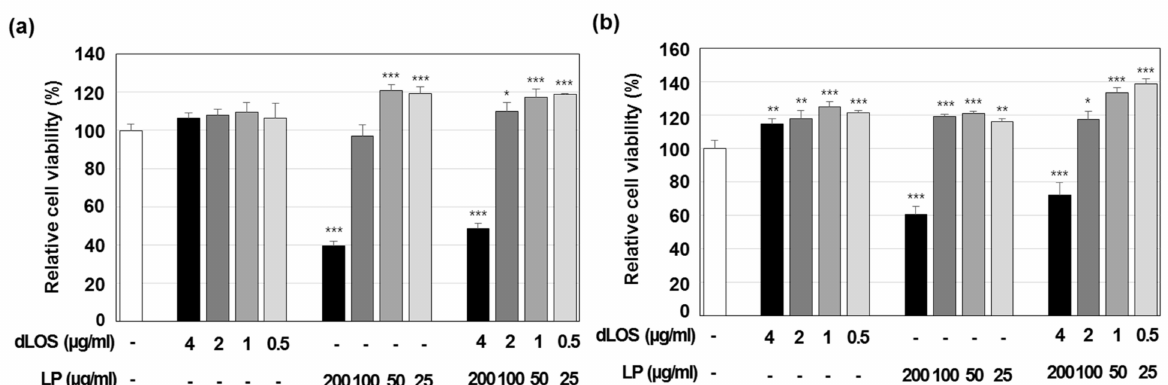
Figure 2. Cytotoxicity of liposomes (LP). MDCK ( a ) and DC2.4 ( b ) cells were incubated with liposomes, dLOS, or both for 24 h, and cell viability was assessed by MTT assays as described in Materials and Methods. Results are expressed as the mean ± SD of values obtained from triplicate assays, and the data shown are representative of at least three experiments with similar results. * p < 0.05; ** p < 0.01; *** p < 0.001 as compared with control